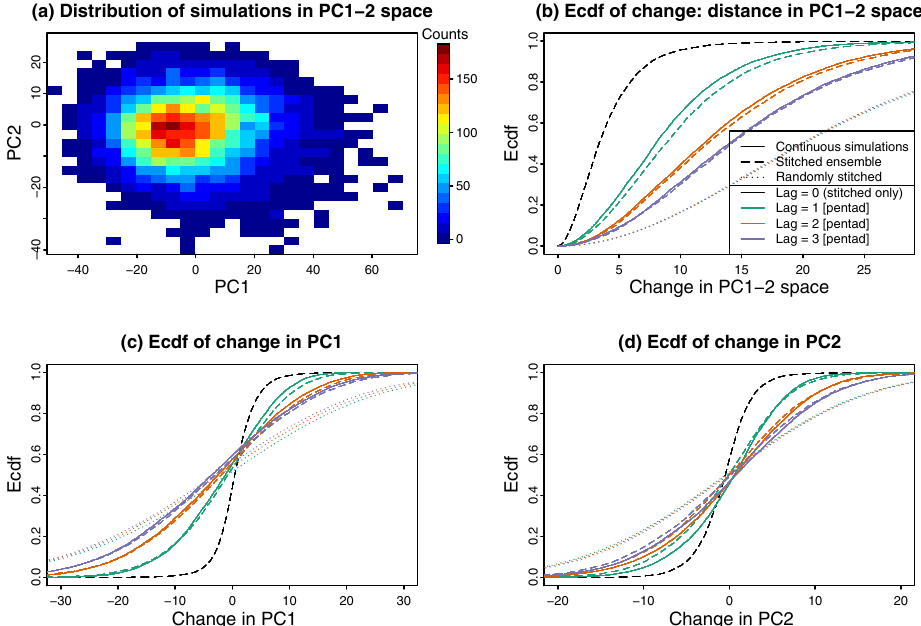
Figure 3. Temporal continuity of soil moisture in the stitched ensemble compared to continuous simulations in the historical baseline (1900–2006). (a) Bivariate distribution of soil moisture PCs 1 and 2 at the last December pentad. (b–d) Empirical cumulative distribution function (ecdf) of the changes in the PC1–2 space between the last pentad in December and the three subsequent pentads (colours) in continuous simulations (continuous lines), the stitched ensemble (thick lines) and a randomly stitched ensemble (points). The dashed black line shows the ecdf of the same distance at the time of stitching, i.e. between the same pentad in stitched simulations. (b) Absolute distance in the PC1–2 space, (c) change in PC1 and (d) change in